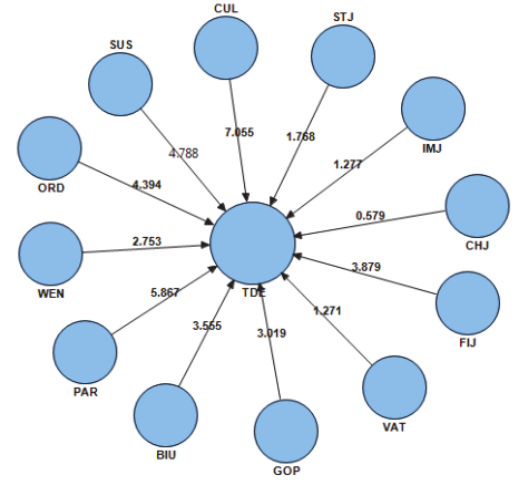
Fig. 3. Standard path coefficients of the concep- tual model of the research